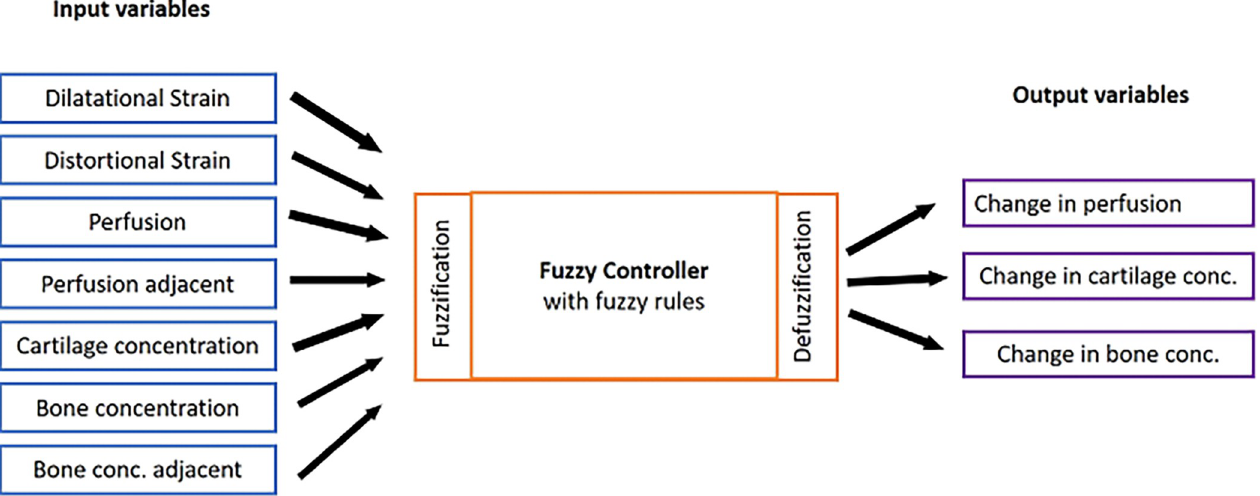
Fig 3. Fuzzy logic controller of tissue differentiation with seven input and three output variables.